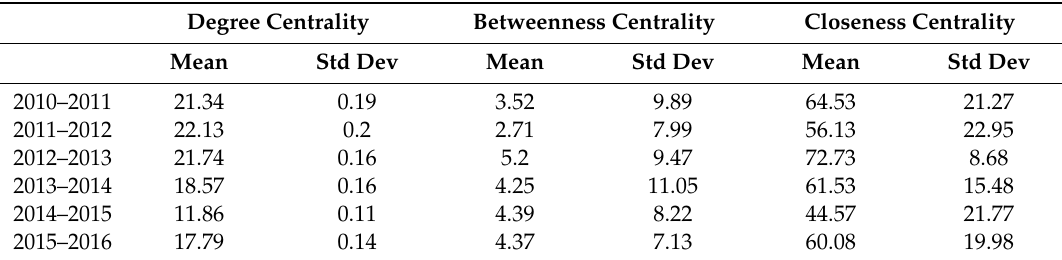
Table 4. Centralities of synergetic networks in Shenzhen from 2010 to 2016. Degree Centrality Betweenness Centrality Closeness Centrality